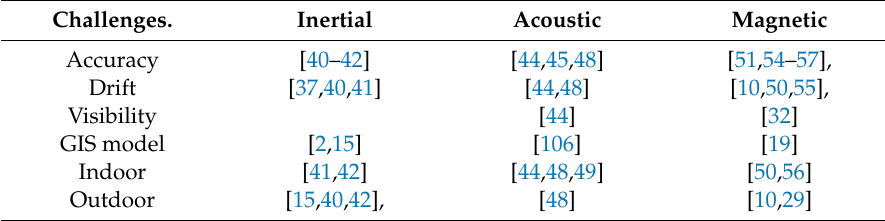
Table 2. Challenges in sensor-based